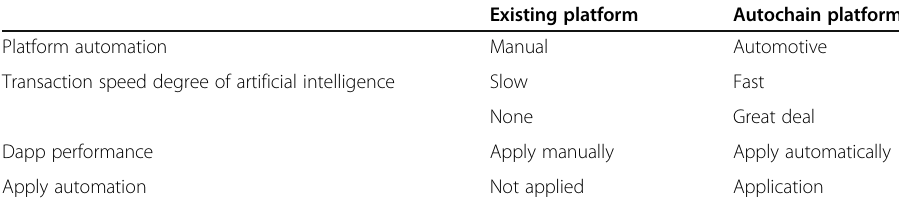
Table 1 Compare Autochain platform